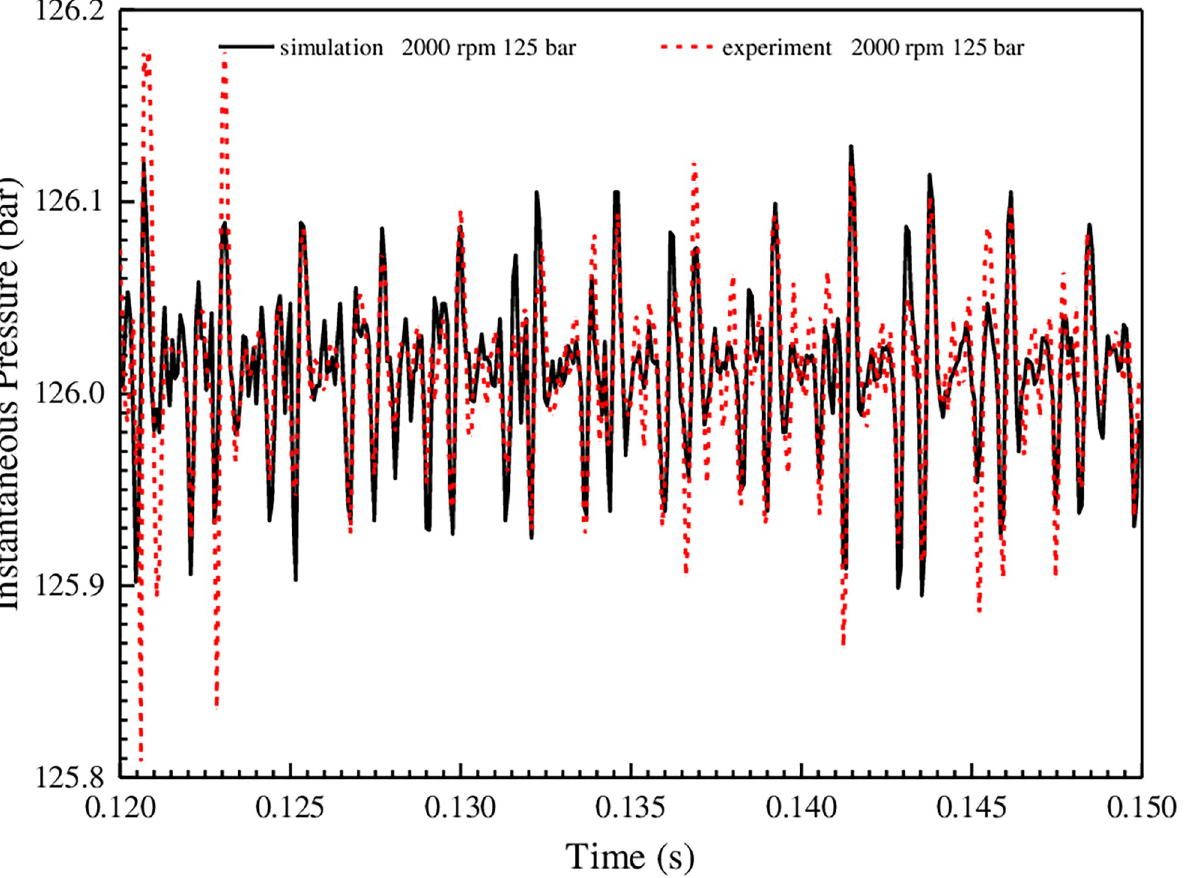
Fig 19. Comparison of instantaneous outlet pressure between experiment and simulation at 12.5 MPa and 2000 r/min.